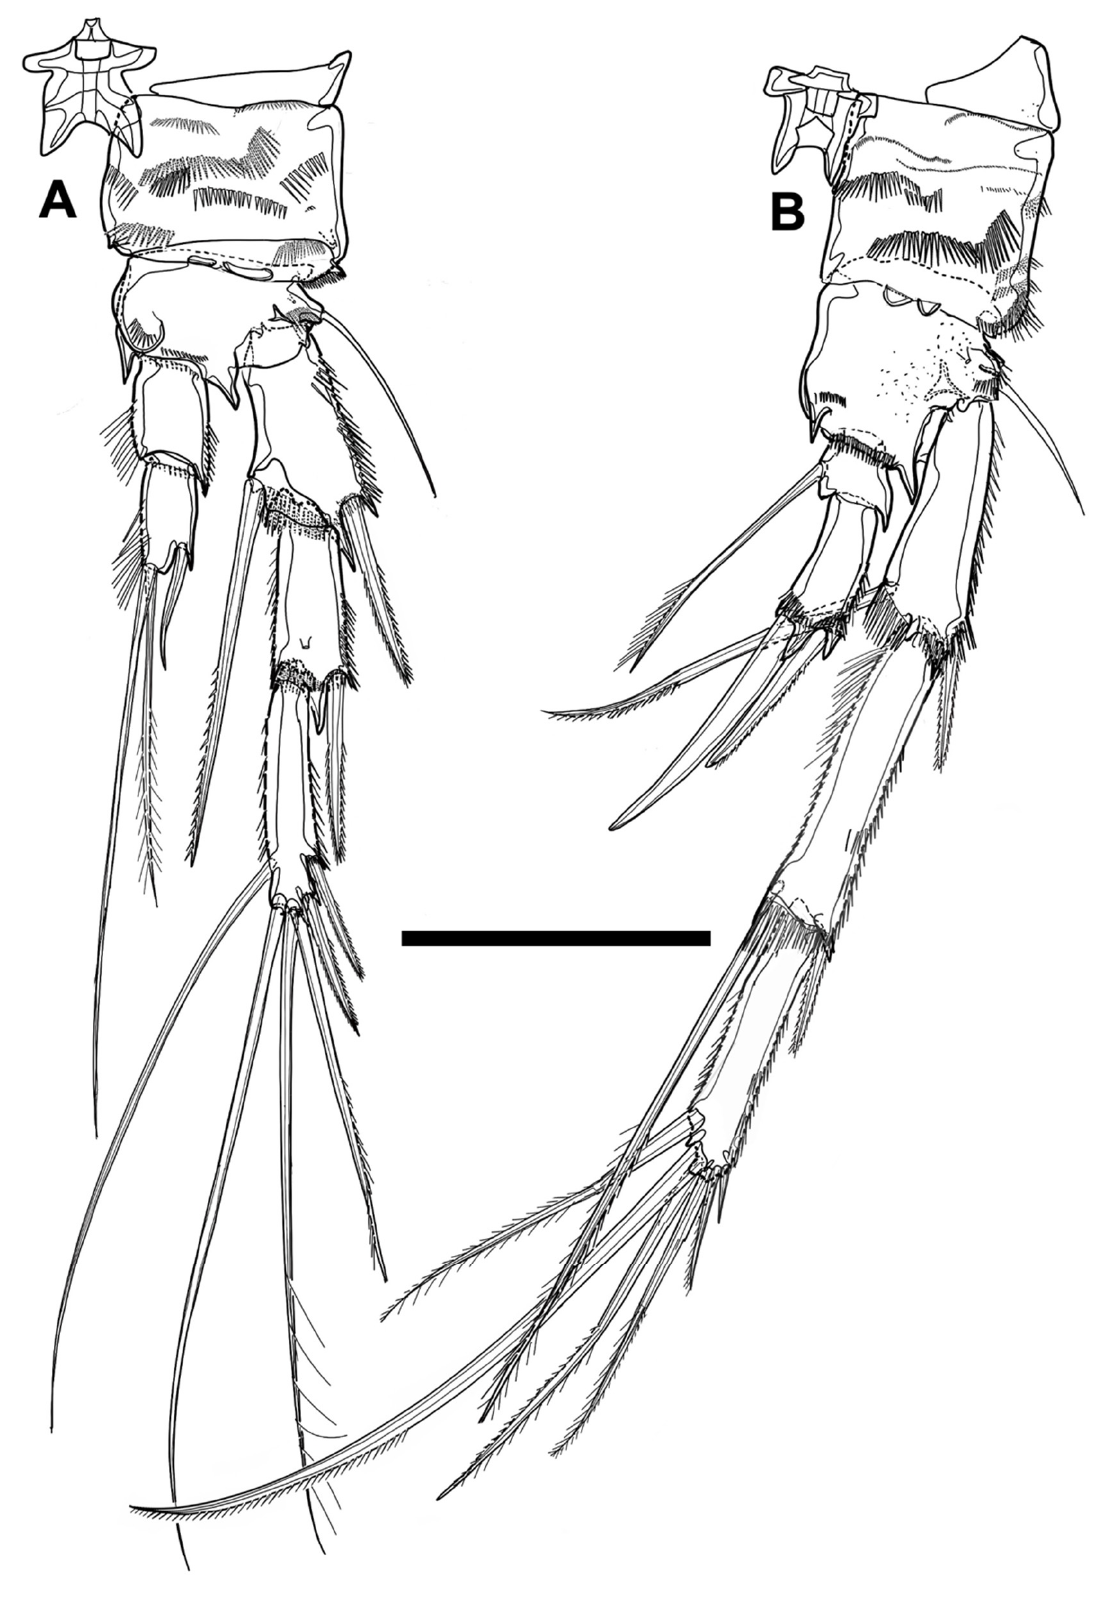
Figure 37. Line drawings of Phyllopodopsyllus similis sp. nov. male (paratype 25): ( A ) P3; ( B ) P4. Scale bar: 50 µm. P3 (Figure 37A) as in female excluding following: Outer armature of second endopo- dal segment somewhat bent terminally, and much deeper embedded than other two setae; other two setae inserted very close to each other P4 (Figures 37B). as in female excluding following: Second endopodal segment about twice as long as wide and armed with two stout spines apically; inner spine longer than